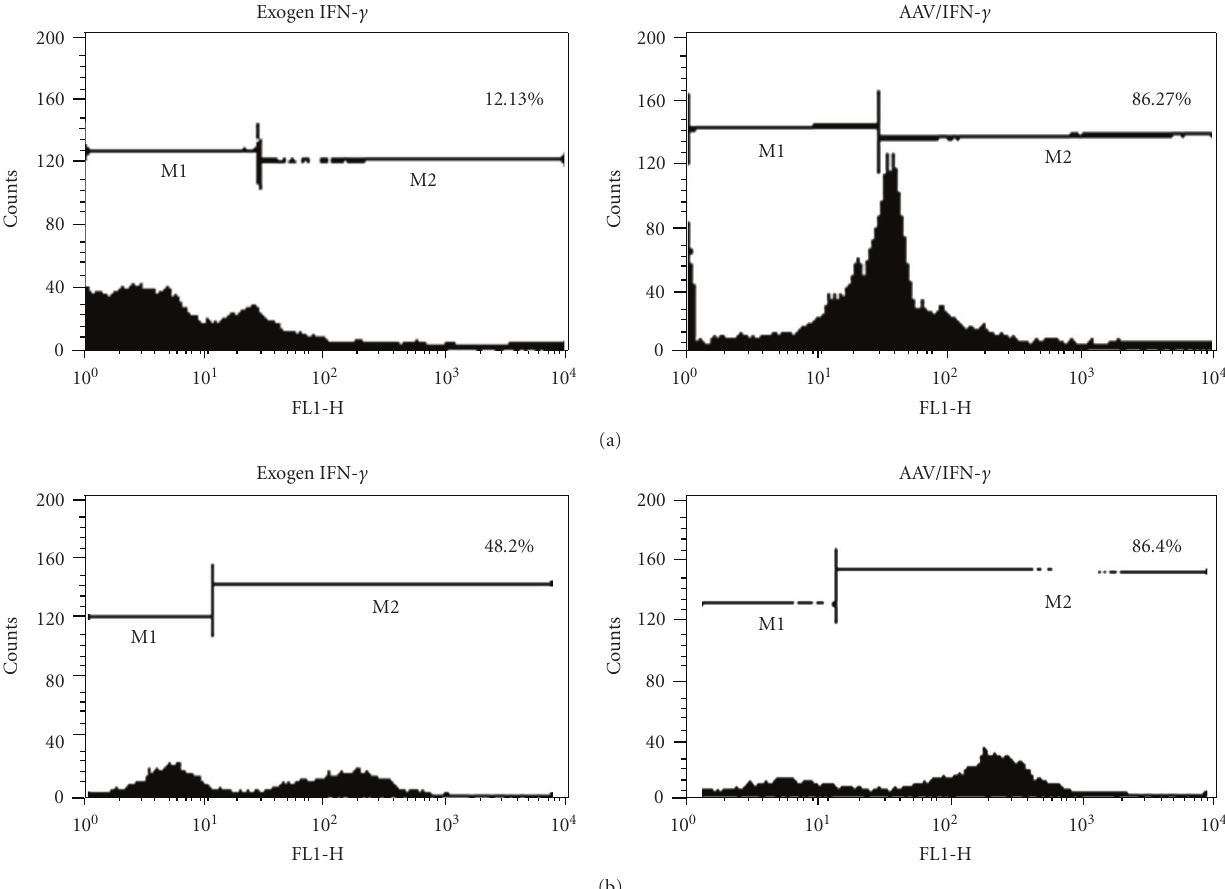
Figure 4: Transduction e ffi ciency of AAV delivery into DC and T cells by intracellular staining. Cells were infected as described in Section 2 and analyzed by intracellular staining for IFN- γ . (a) shows the results from DC infection. (b) shows the results from T cell infection. Note that both AAV/IFN- γ transduced DC and T cells demonstrate high levels of IFN- γ expression, but that T cells exhibit a signifiucant basal level of